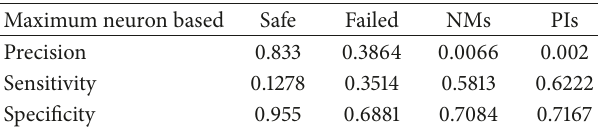
Table 4: Maximum neuron based SSSOM performances: precision, sensitivity, and specificity for each class.